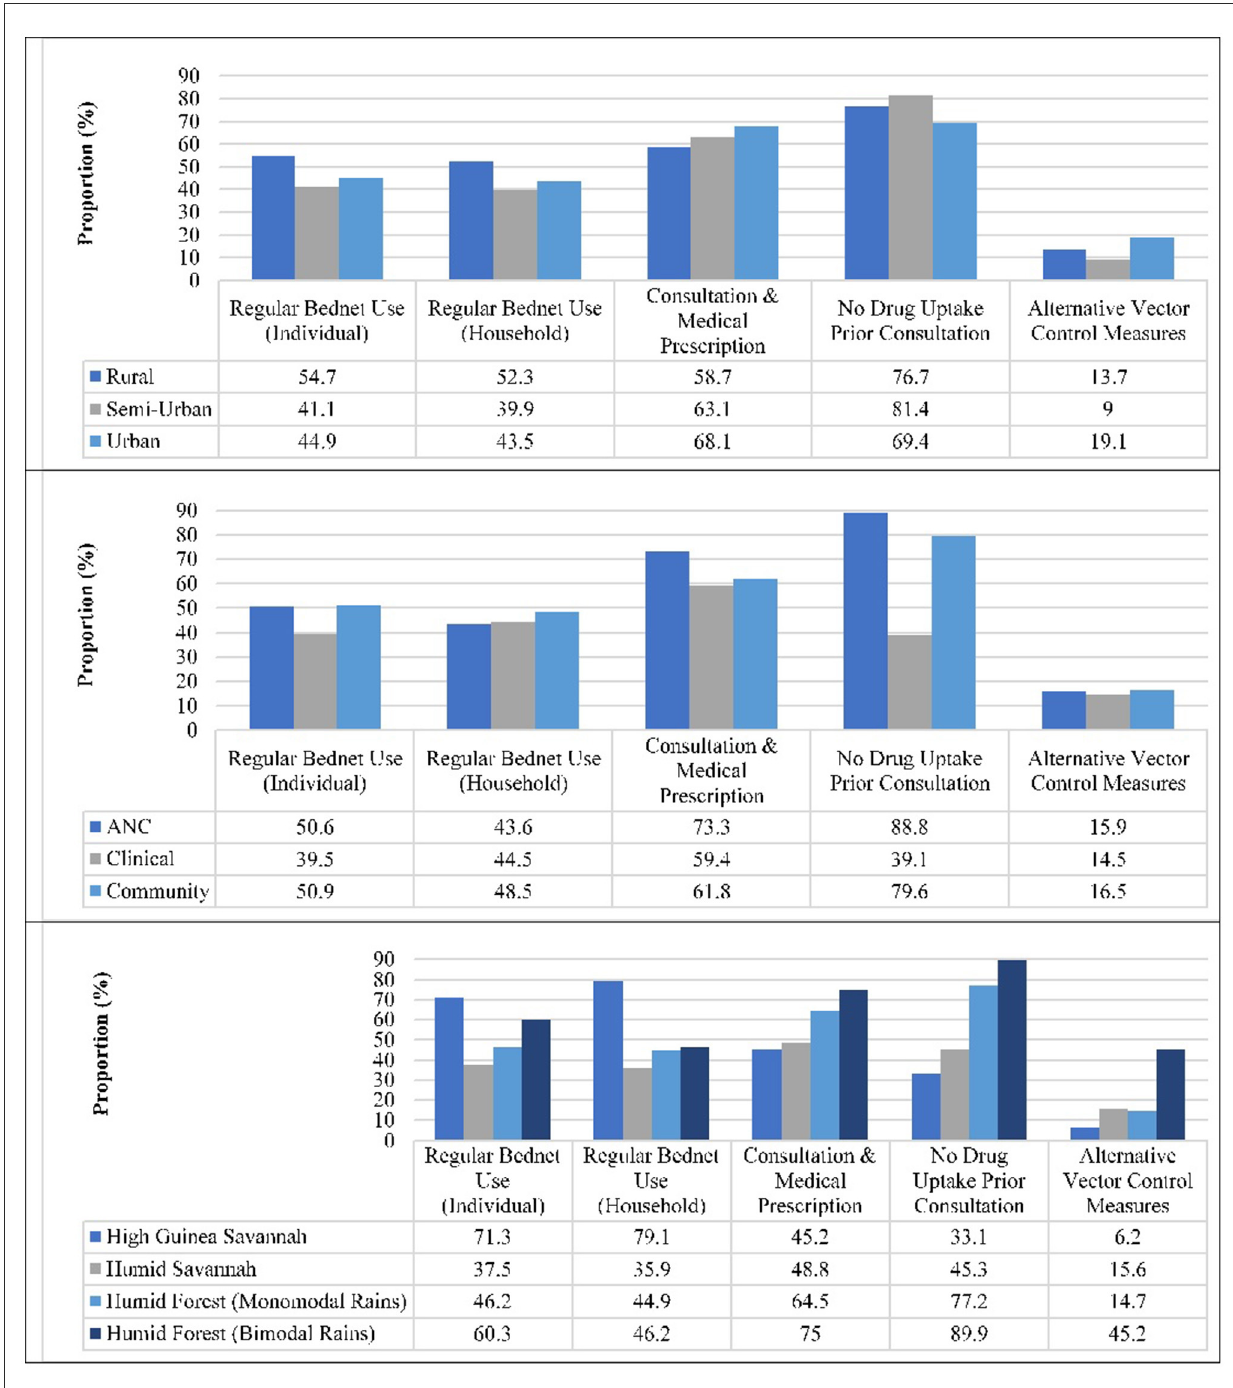
FIGURE3 Positive attitudes and practices toward malaria control in Cameroon.